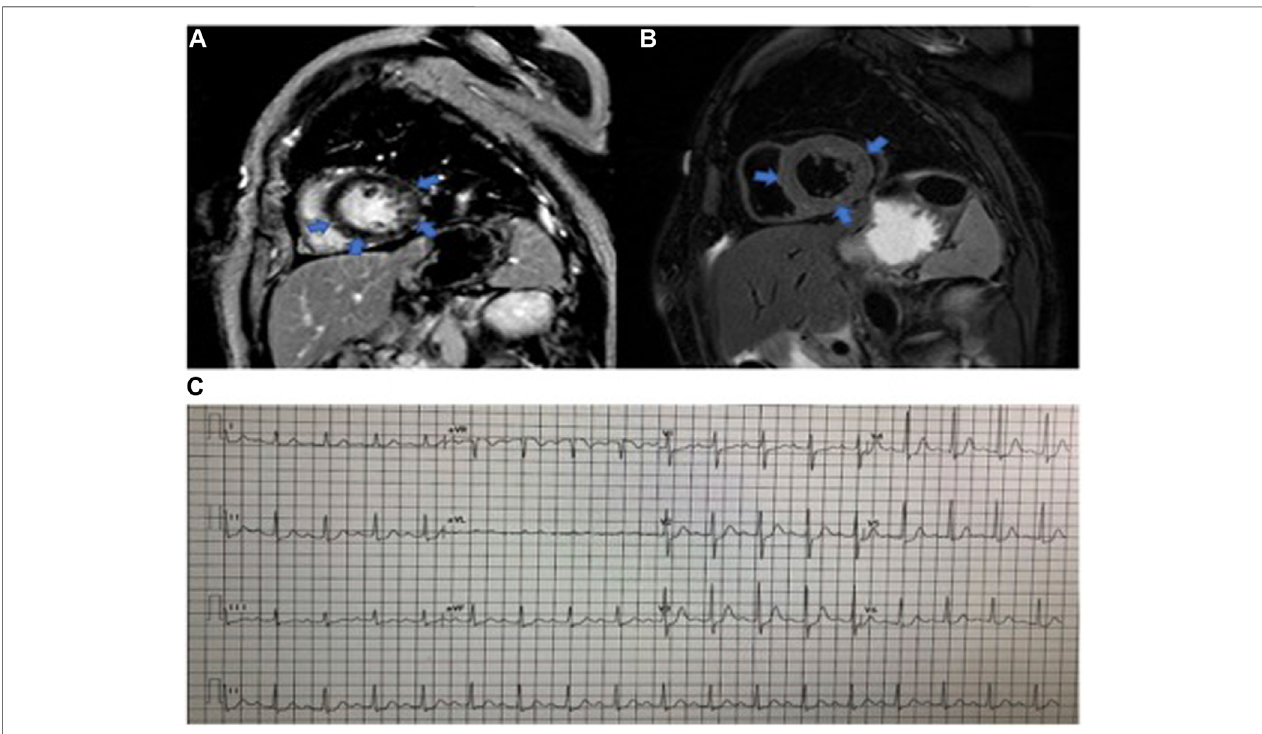
FIGURE 2 | Cardiac magnetic resonance imaging of myocarditis. (A) LGE image of fi brosis. (B) . Precontrast T2-weighted image of the same slice location as the image in the same patient. (C) . Eelectrocardiogram abnormalities: the prolongation of the PR interval, sinus tachycardia, and ST changes.